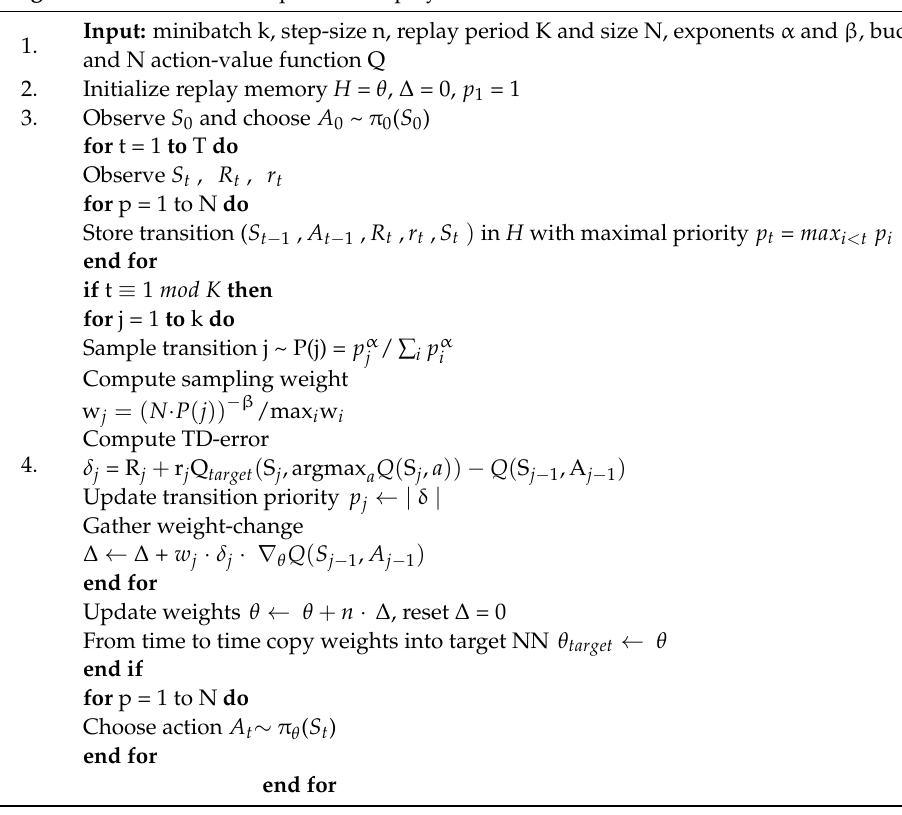
Algorithm 4: Prioritized Experience